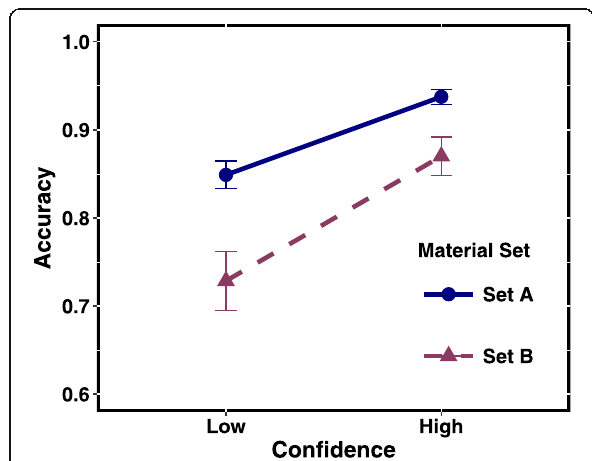
Fig. 4 Comparison of the easy (Set A) and difficult (Set B) materials. Error bars indicate standard